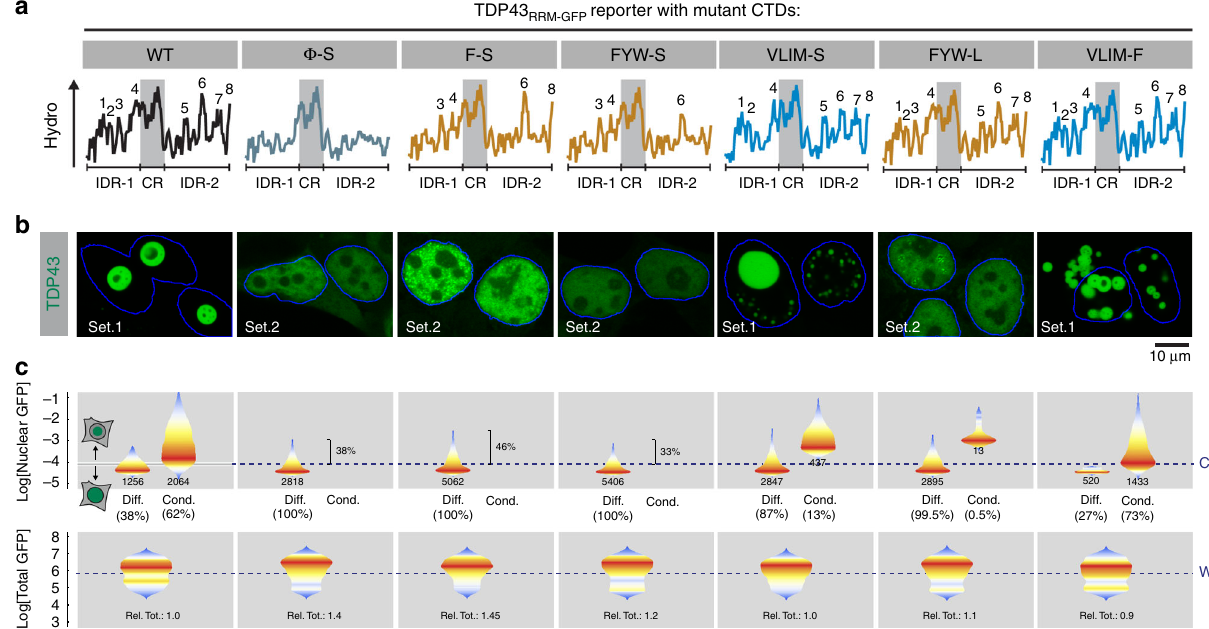
Fig. 2 Aromatic residues drive phase separation of TDP43. TDP43 RRM-GFP reporter constructs carrying the indicated mutations were transiently transfected into HEK-293T cells and analyzed by high-throughput automated confocal microscopy and fl ow cytometry. a Hydrophobicity plots for each CTD, with numbers highlighting the major hydrophobic clusters. b Representative confocal images (63×) of cells transfected with various TDP43 RRM-GFP constructs. Blue outline demarcates nuclei; Set1 and Set2 indicate two different photomultiplier gain settings used for optimal display only. c Quanti fi cation of nuclear TDP43 RRM-GFP levels in cells with ( ‘ Cond ’ ) or without ( ‘ Diff ’ ) condensates measured by confocal images (20×) and total TDP43 RRM-GFP levels measured by fl ow cytometry. Data are presented as violin plots, with color-coding representing the probability density of cells in a particular fl uorescence bin (blue: lowest probability density; red: highest probability density). Numbers and percentages below each graph re fl ect the absolute and relative number of transfected cells with (Cond) or without (Diff) TDP43 RRM-GFP condensates, respectively. For cells without condensates, percentages within in each graph re fl ect the number of cells with nuclear TDP43 fl uorescence above the estimated critical concentration for phase separation. For total TDP43 RRM-GFP levels (bottom row), “ Rel. Tot. ” denotes the overall median cellular abundance of each CTD variant relative to the WT ( n ≥ 10,000 cells). Dashed blue lines indicate the C sat of WT TDP43 RRM-GFP (C sat ) or the median total abundance of WT TDP43 RRM-GFP (WT), mutations in the context of full-length TDP43 to study their effect on splicing.